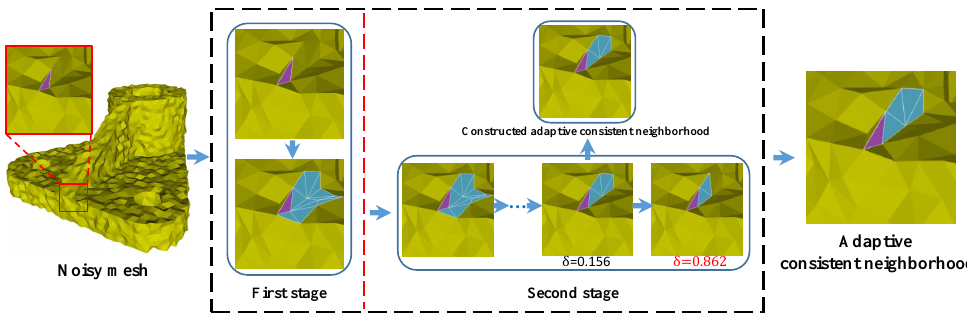
Figure 1. The consistent neighborhood selected by H [21] and C. C is computed from Equation (2). The neighborhood framed by red and blue dashed box are selected by C and H, respectively.